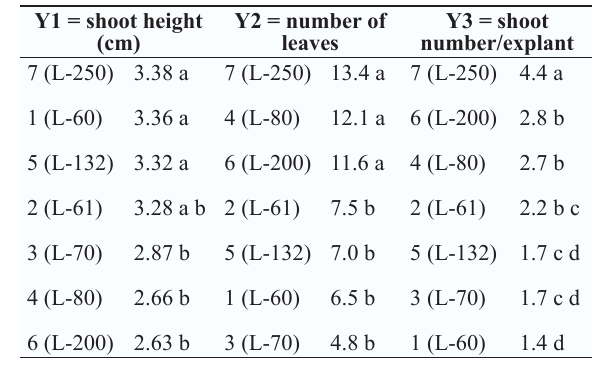
Table 2. Morphological parameters for seven thorny artichoke ( Cynara scolymus L.) clonal lines at the end of the